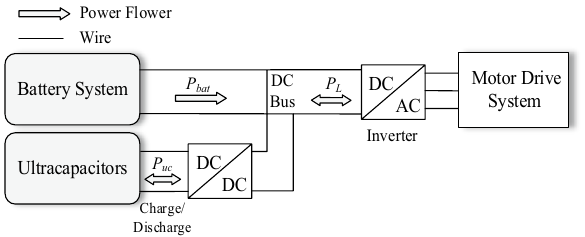
Fig. 1 Topological structure of hybrid power supply